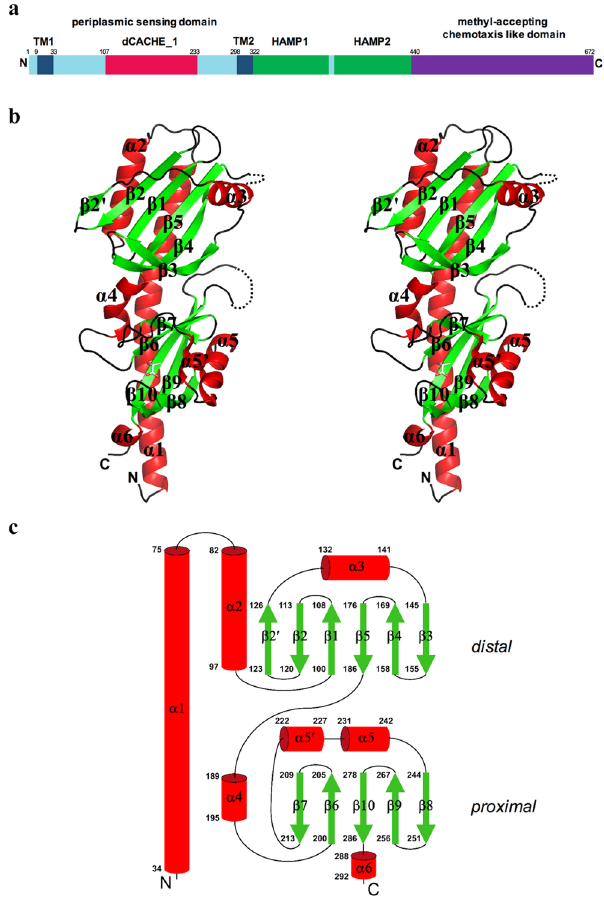
Figure 1. Overall fold of TlpC dCACHE LBD. ( a ) Domain organisation of TlpC, showing LBD location with respect to other structural elements. Transmembrane region (TM, dark blue); dCACHE_1 domain (red), HAMP domains (green); methyl-accepting chemotaxis-like domain (purple). ( b ) Stereo representation of structure of TlpC LBD monomer. ( c ) Topology of secondary structure elements of TlpC LBD. The α -helices are represented by rods and β -strands by arrows. The membrane-distal and membrane-proximal subdomains are